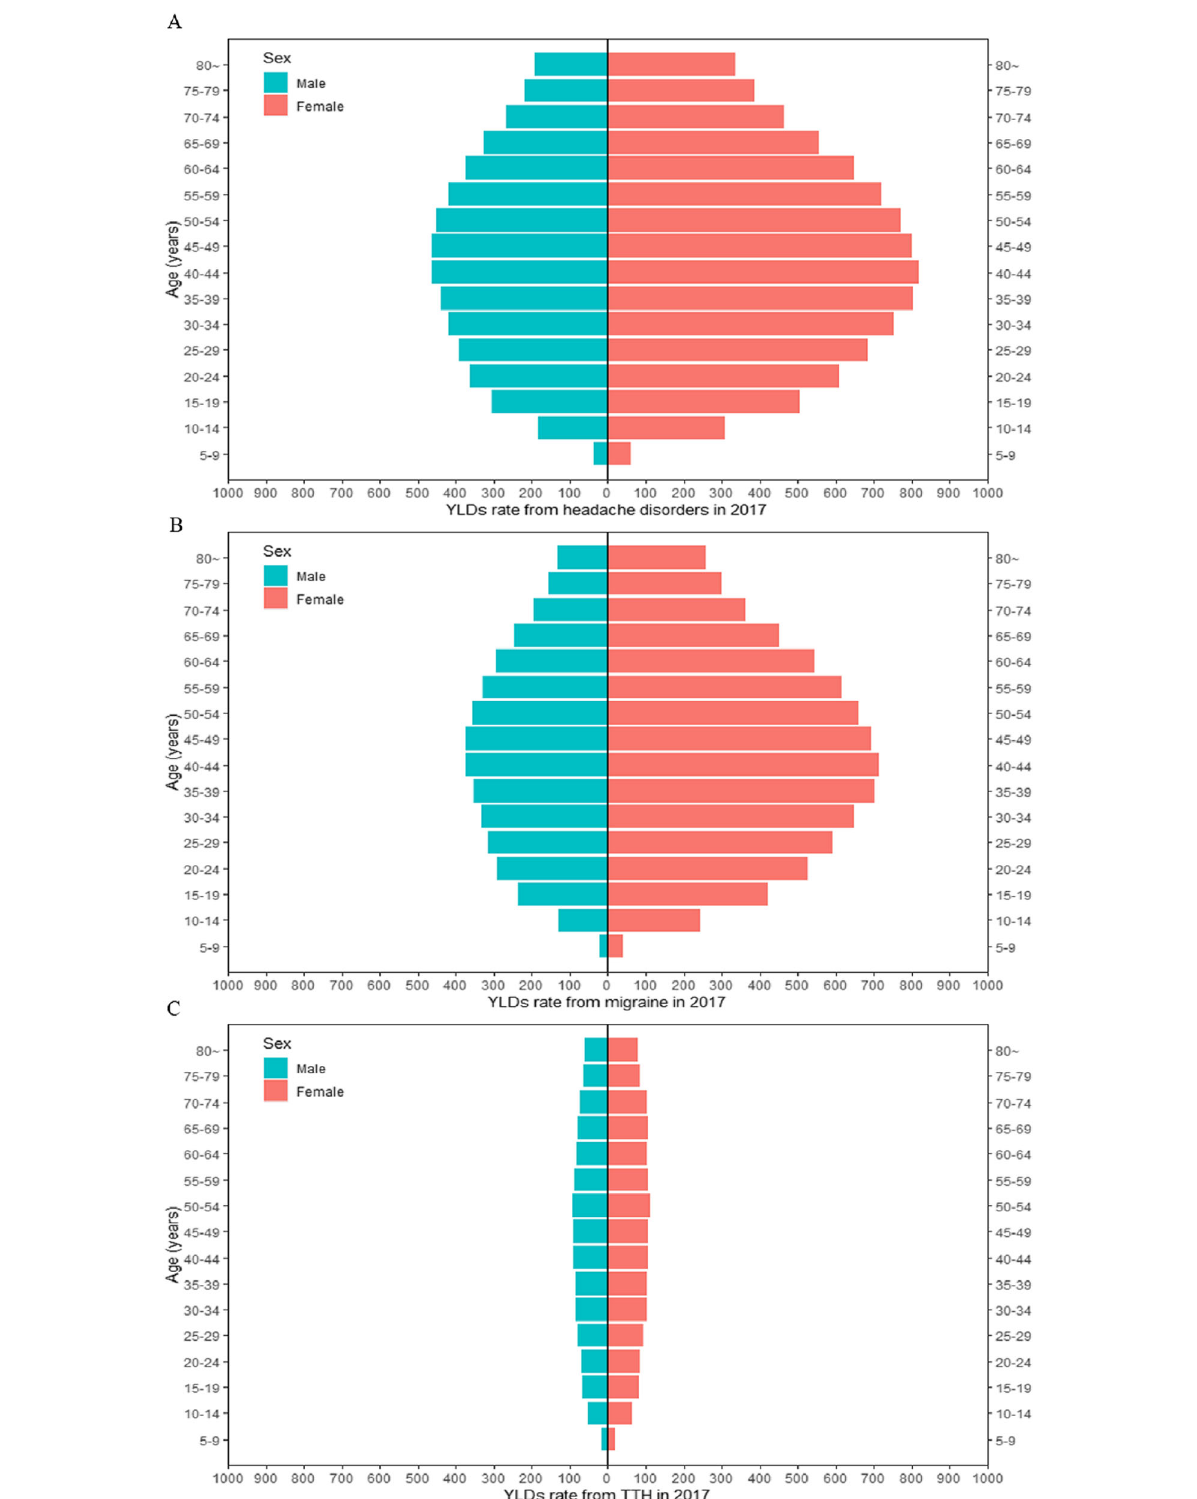
Fig. 2 Age-sex-specific YLDs rate from headache disorders in China in 2017. Note: a the YLDs rate from headache disorders by age bands and sexes; b the YLDs rate from migraine by age bands and sexes; c the YLDs rate from tension-type headache by age bands and sexes. Abbreviation: YLDs: years of life lived with